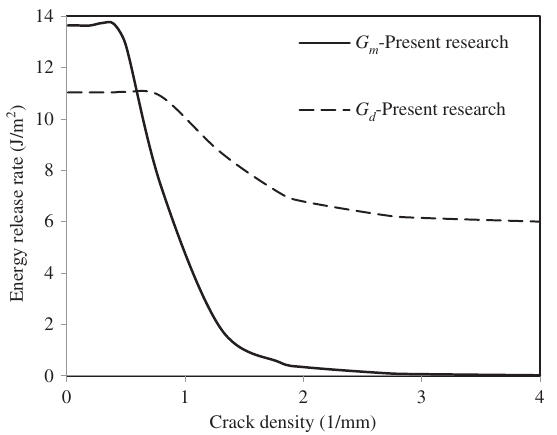
Figure 16: Crack density vs. energy release rate for [40/−40 epoxy laminate under σ